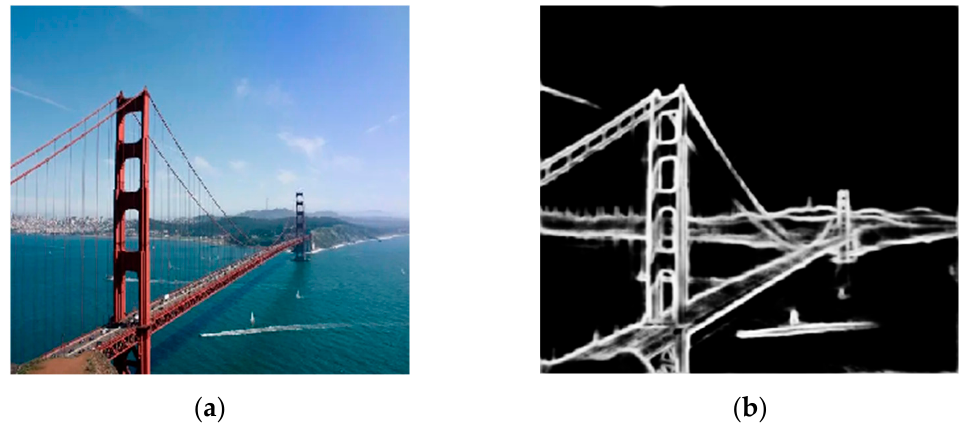
Figure 1. Edge detection results of HED network on natural images. ( a ) Bridge original image; ( b ) Bridge image HED network edge detection.